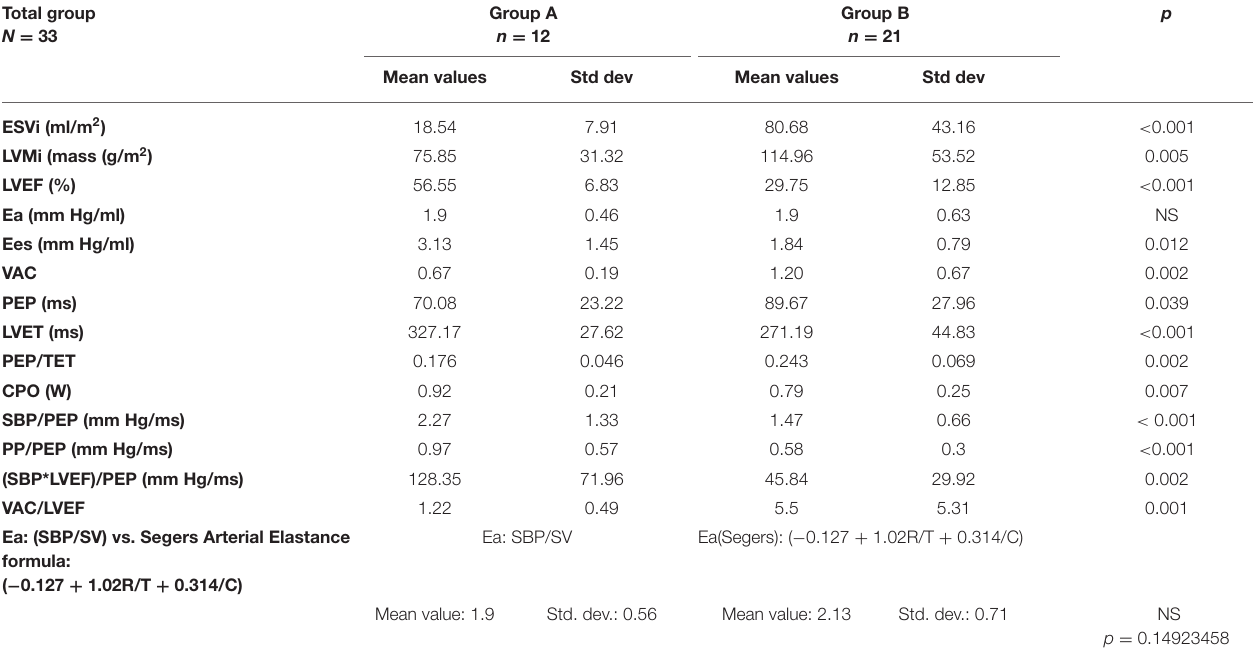
TABLE 2 | Hemodynamic variables in the two groups. Total group N =